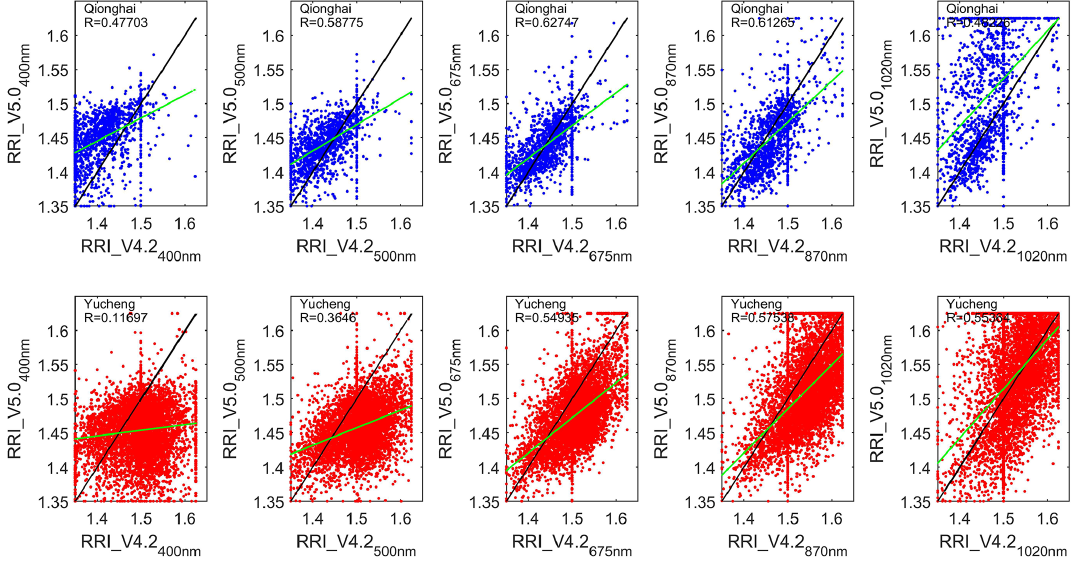
Figure 8. The same as Fig. 7 but for the real part of the complex refractive index ( m r ).